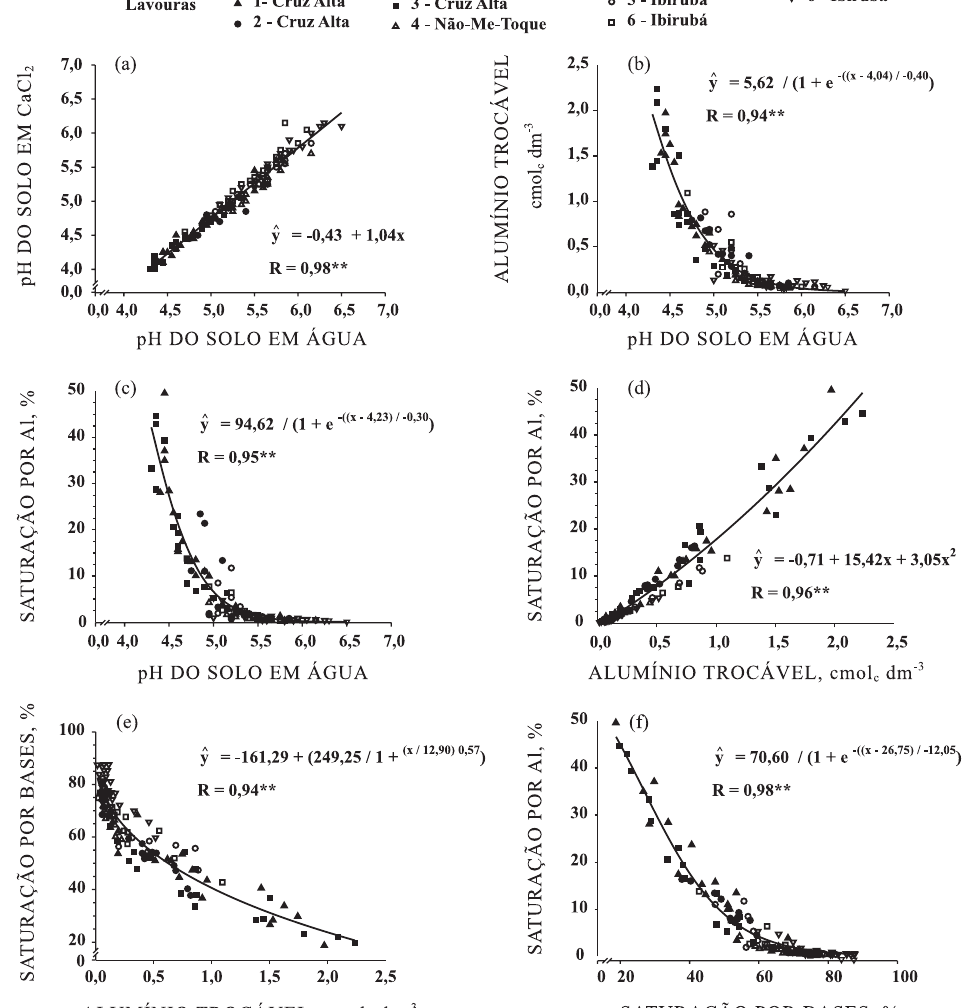
Figura 4. Relação entre o pH em água e o pH em CaCl (a), o alumínio trocável (b), a saturação por alumínio 2 (c), entre o alumínio trocável e a saturação por alumínio (d), a saturação por bases (e) e entre a saturação por bases e a saturação por alumínio (f), em amostras de solo coletadas na camada de 0–20 cm de profundidade, em lavouras no